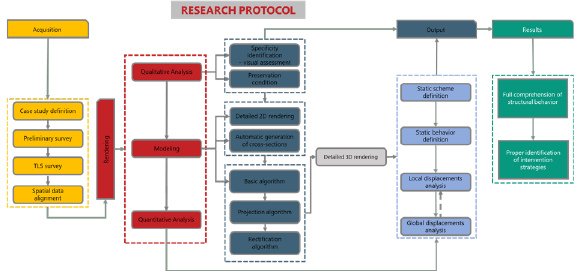
Figure 1: Investigation protocol